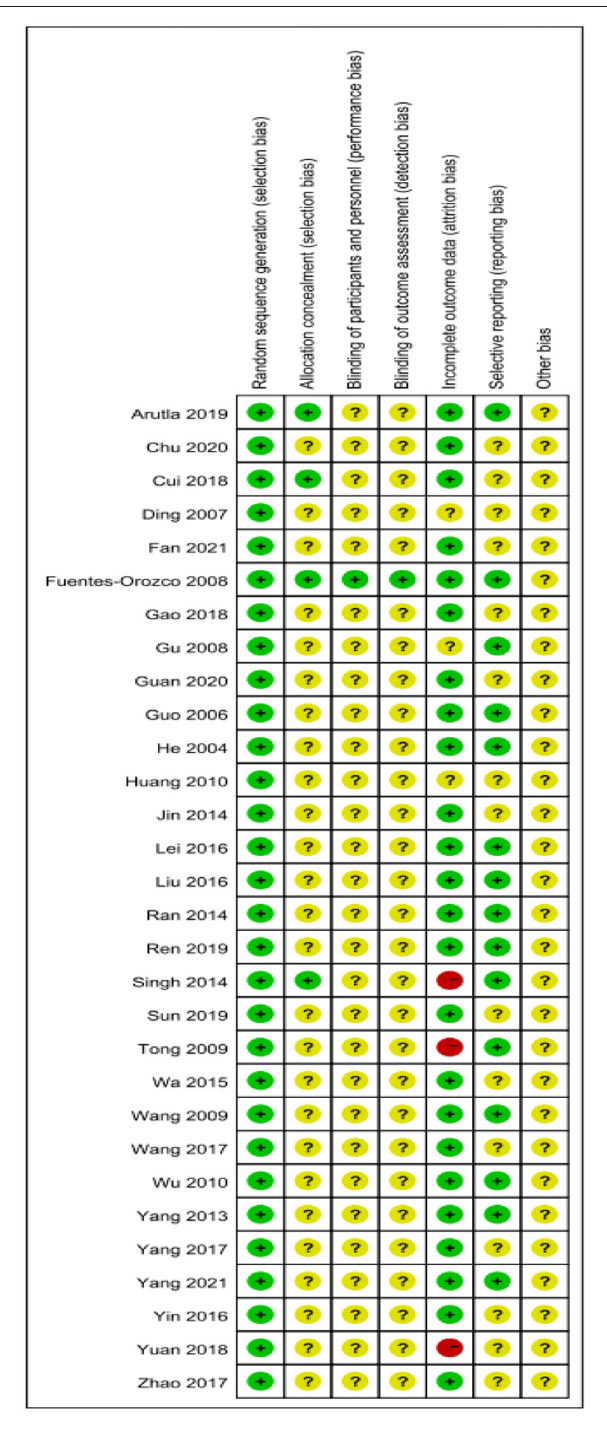
FIGURE 2 | Risk of bias summary.